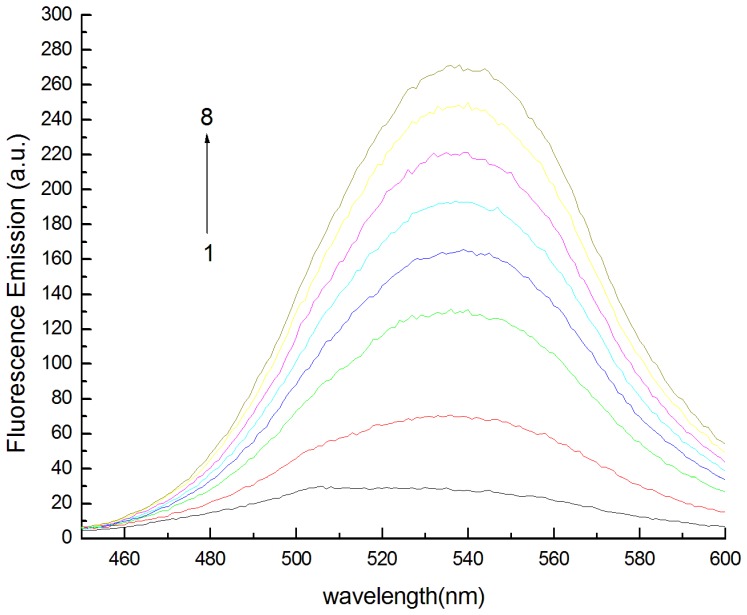
Fluorescence emission spectra.Cβ-CD: from top to bottom(1–8):0.0, 2.0,4.0,6.0,8.0,10.0,12.0, 14×10−4 mol/L. pH = 9.00, Cberberine hydrochloride = 2.00 µg/mL.